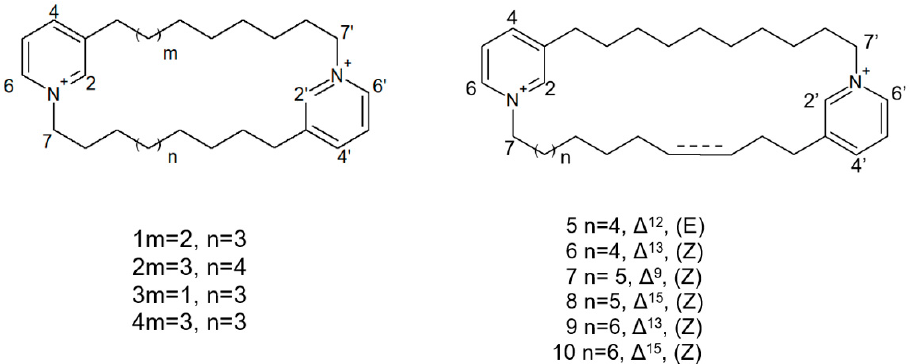
Figure 18. Structures of cyclostellettamine N (1), cyclostellettamine Q (2), and the other eight bis-1,3- dialkylpyridinium compounds extracted from species of the genus Haliclona (3–10).